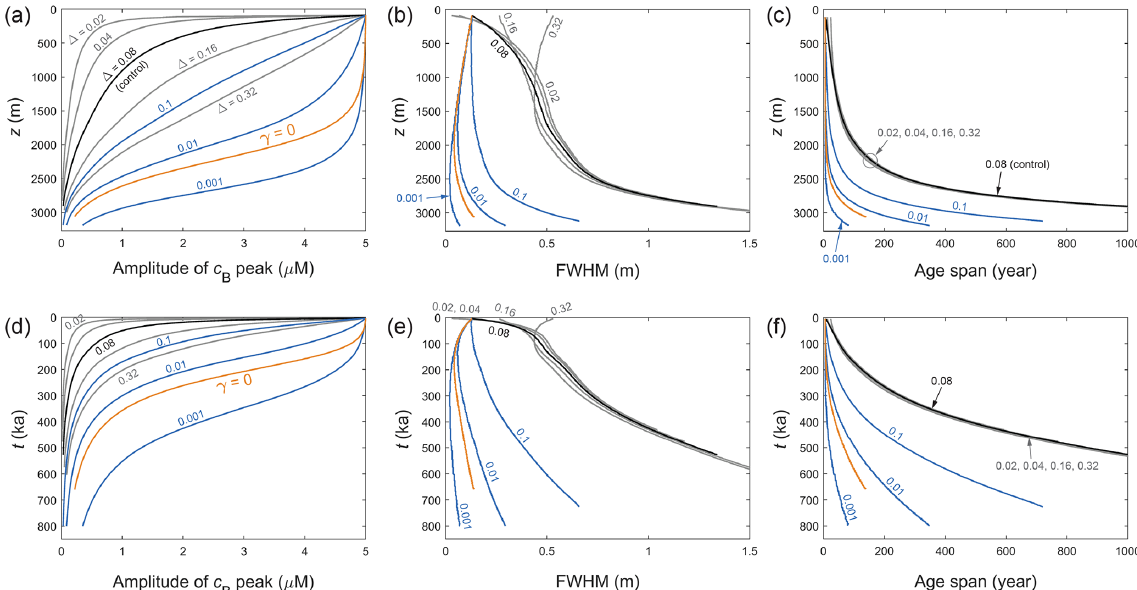
Figure 8. Changing morphometry of the signal peak – its amplitude, full width at half maximum (FWHM), and age span – in the EPICA ice core for different model parameters, plotted against depth (a–c) and age of the ice (d–f) . Black curves plot the control run of Fig. 6a, and orange curves plot the γ = 0 run of Fig. 6d. Grey and blue curves document the same sensitivity tests as conducted for the GRIP core (see Fig. 7 caption for details). The FWHM and age-span axes are scaled to focus more on the blue and orange curves, rather than the deep ends of the grey/black curves, as the corresponding signal amplitudes decay to near